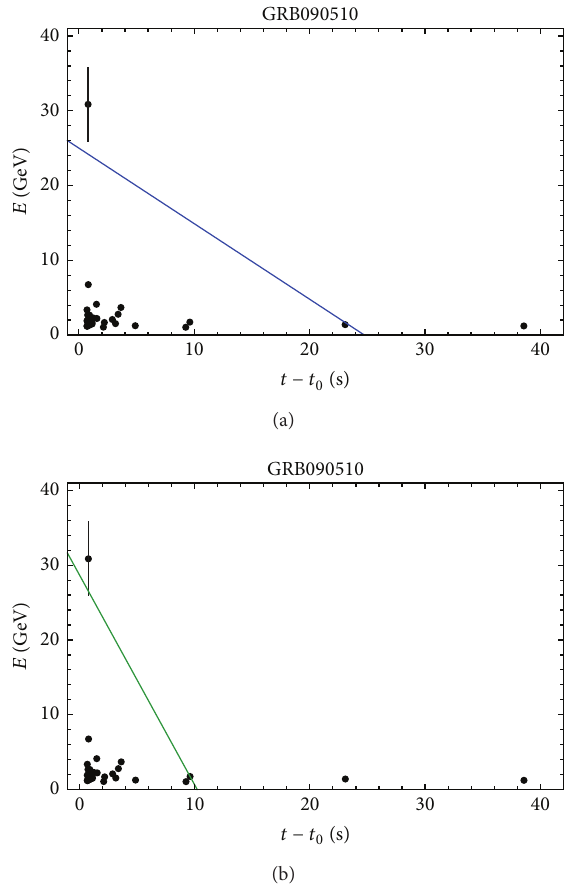
Figure 14: Here shown is the Fermi-LAT sequence of photons with energy greater than 1GeV for GRB090510. We visualize an error bar at the 15 % level for the energy of the most energetic event. (b) A straight line with the slope we derived in Section 3. (a) A straight line with slope obtained from the slope derived in Section 3 by rigidly rescaling it by the factor of 𝐷(0.34)/𝐷(0.897) (0.897 being the redshift of GRB090510), as dictated by